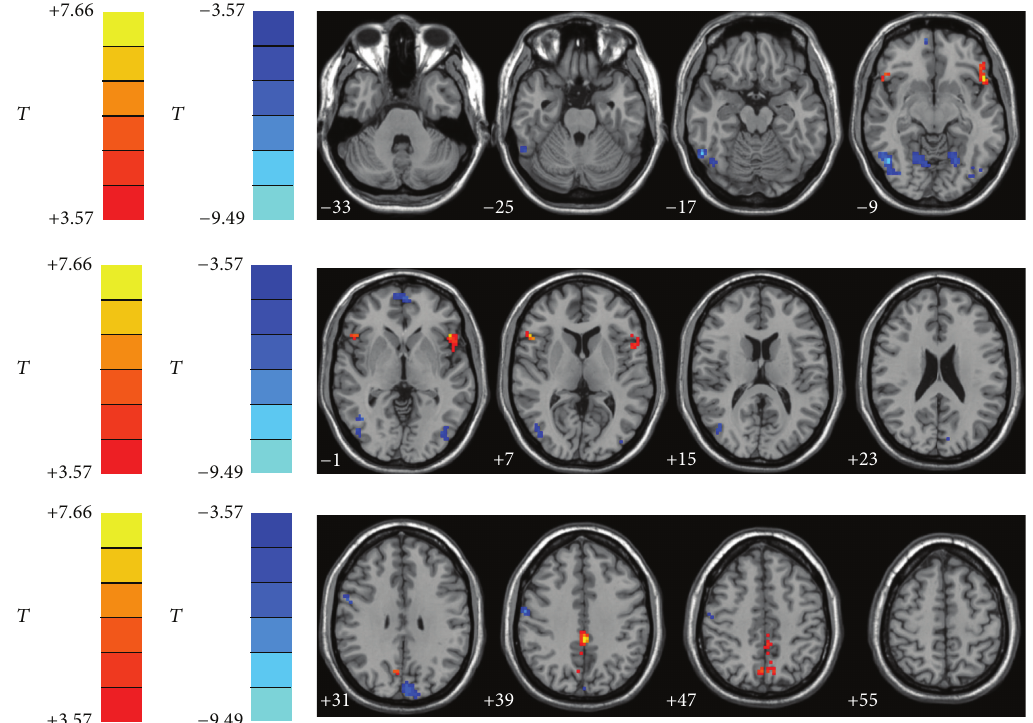
Figure 1: Altered ALFF in PT patients in comparison with controls (two-sample 𝑡 -tests).